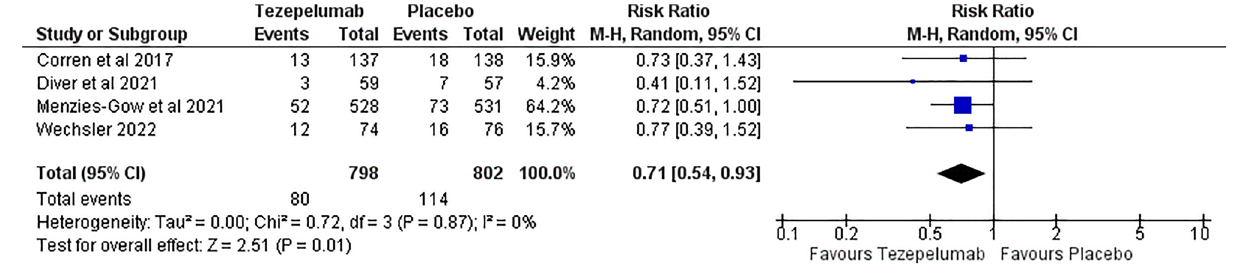
Figure 12. Any adverse effects